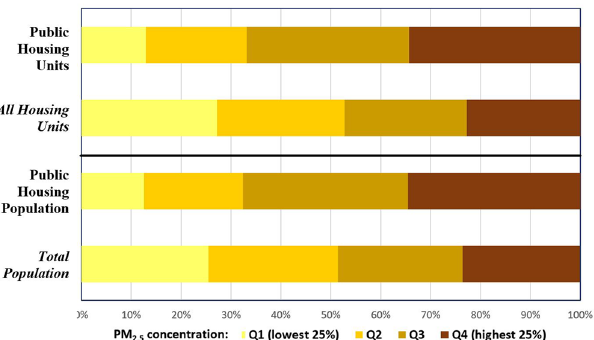
Figure 2. Distribution of housing units and population in the continental US by census tract quartile of PM 2.5 concentration. Note: In each quartile, annual average particulate matter (PM 2.5 ) concentrations in micrograms